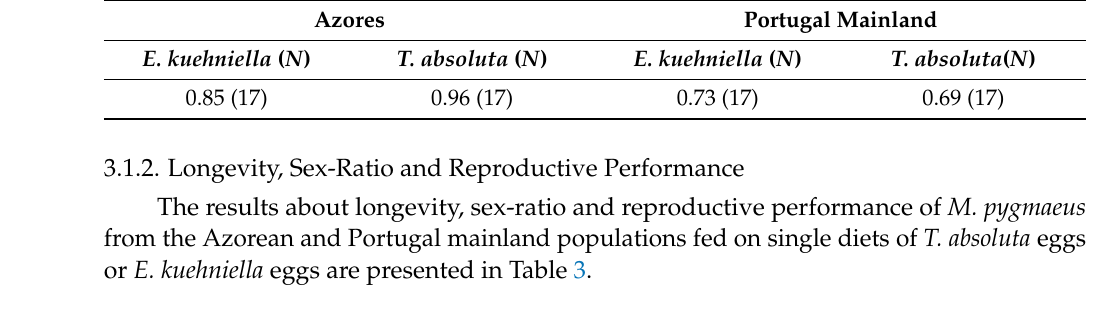
Table 3. Adults’ life-history traits of Macrolophus pygmaeus of the Azorean and Portugal mainland populations fed on single diets of Ephestia kuehniella or Tuta absoluta eggs (25 ± 1 ◦ C; 75 ± 5% relative humidity and light regime 16L:8D). The information on the two additional columns (signifi- cance) stands for biological traits in which no significant effect between factors we found (origin of population and food